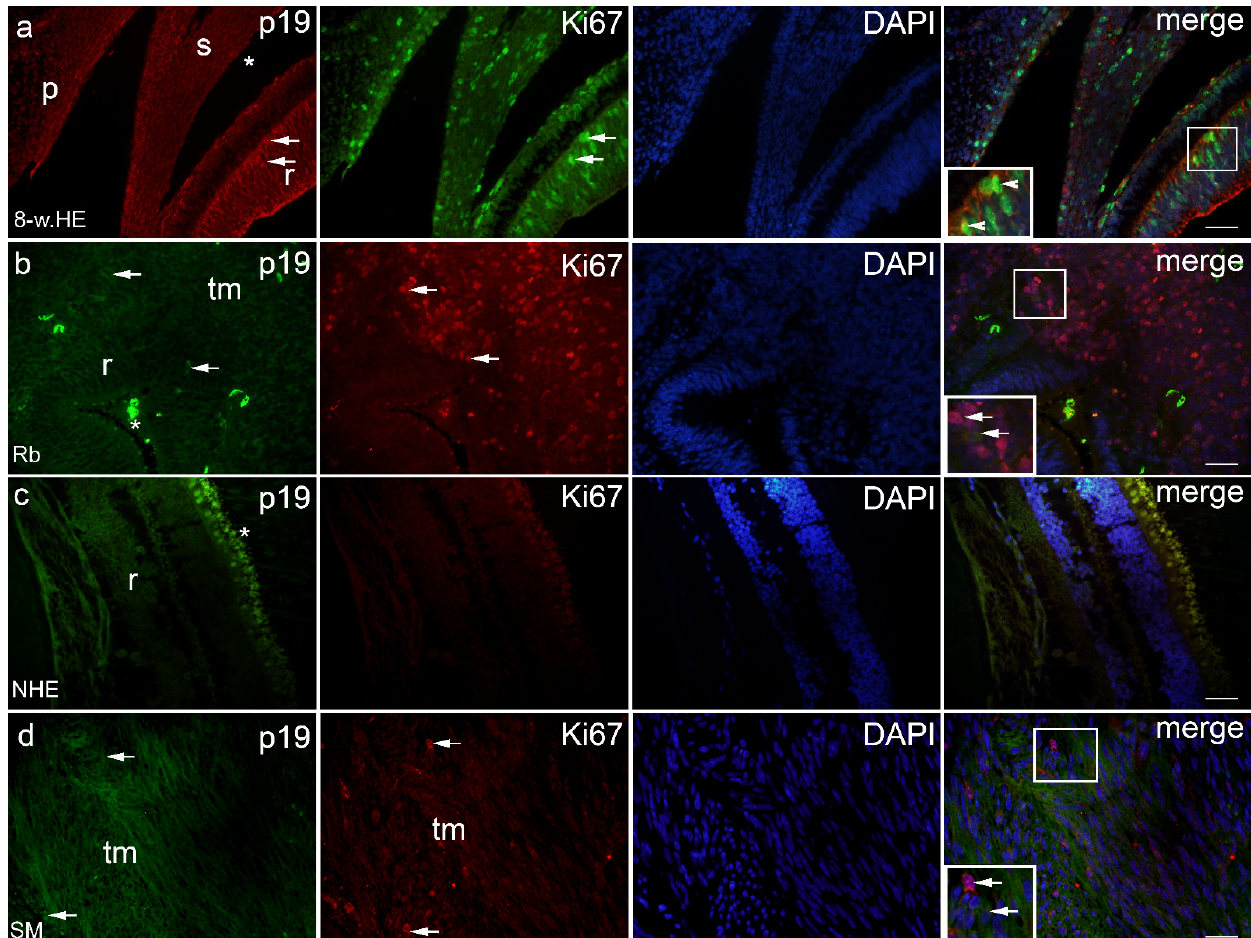
Figure 2. p19 and Ki67 positive cells (arrows) can be seen in the eye section of an 8-week human embryo-8-w.HE ( a ), retinoblastoma–Rb ( b ), normal human eye–NHE ( c ) and spindle melanoma-SM ( d ); r—retina, *—choroidea, tm—tumor tissue, s—sclera, p—palpebra. Co-localization of p19 and Ki67 positive cells can be seen in panel ( a ) (arrowheads). Double immunofluorescence staining to p19 (first column), Ki67 (second column), DAPI (third column), merge (fourth column). Magnification frames provide detail with positive cells (arrows) or co-localization (arrowheads). Scale bar for all panels is 25 μ m.